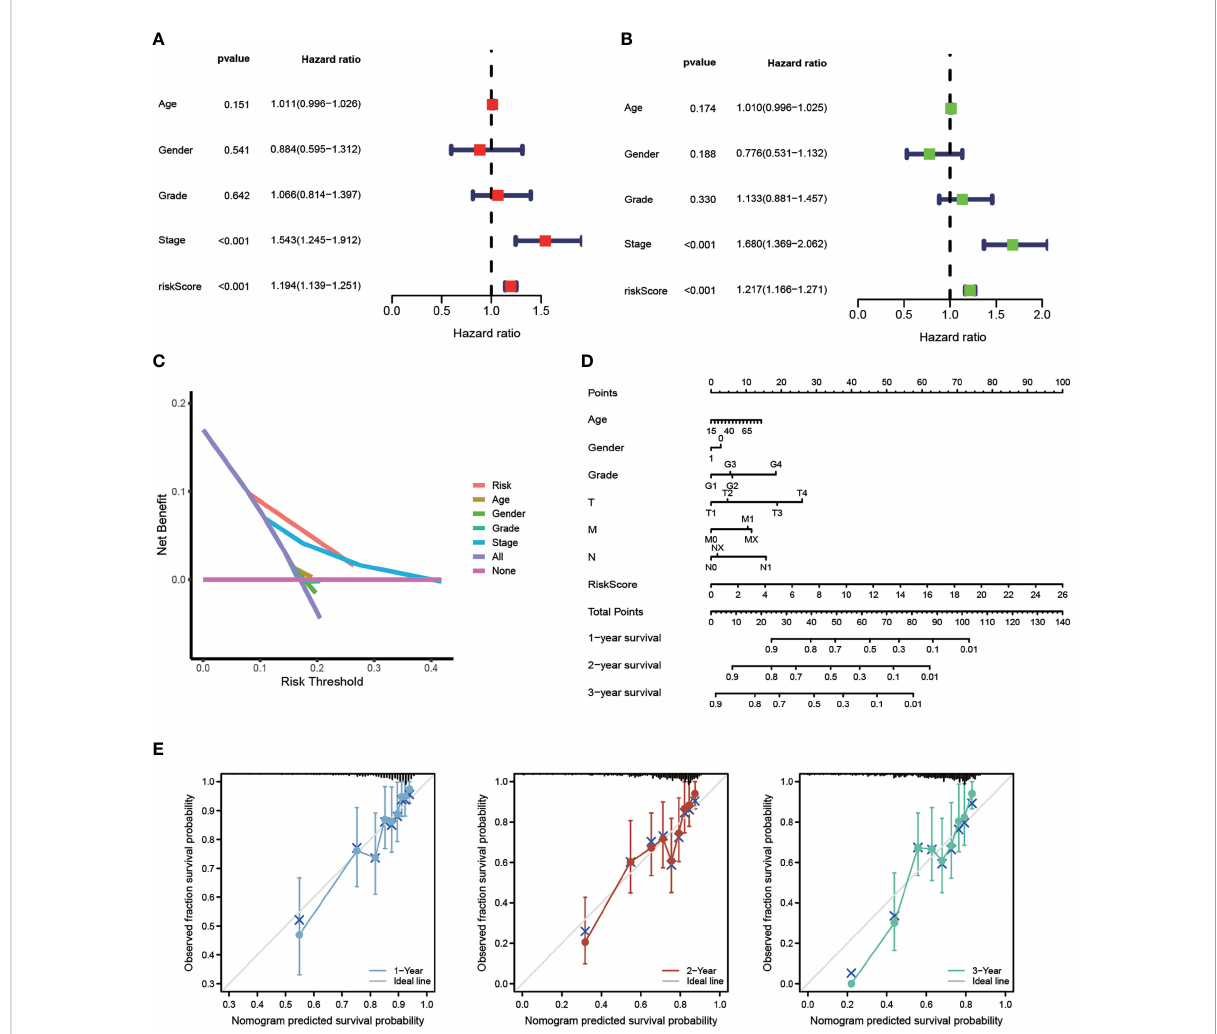
FIGURE 5 Independent Prognostic Value of The Model. Univariate Cox (A) and Multivariate Cox (B) analysis to assess the independence of the model. (C) DCA was performed to present the net bene fi t of risk score compared to clinical parameters. (D) Nomogram survival prediction of HCC patients with risk score. (E) Calibration plot of the nomogram (*p < 0.05, **p < 0.01, ***p <